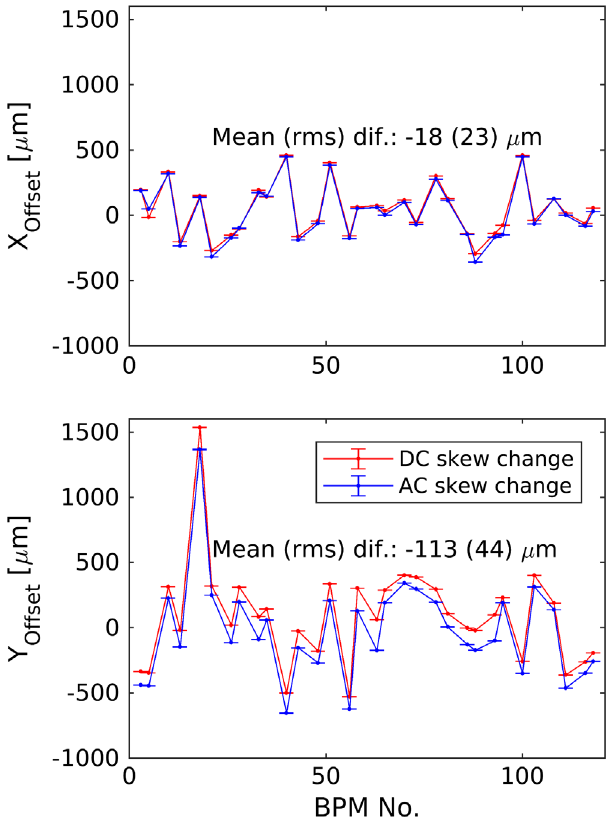
FIG. 17. Reproducibility of both dc and ac skew quadrupole FBBA for the BPM no. 21 (6th skew quadrupole) in the horizontal plane with (curves 1) and without (curves 2) magnetic